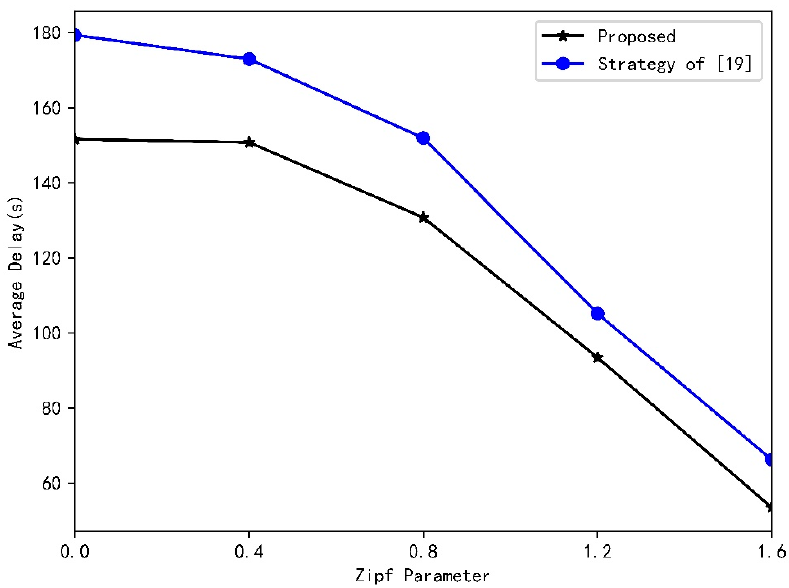
Figure 11. The relationship between Average Delay and Zipf distribution parameter.